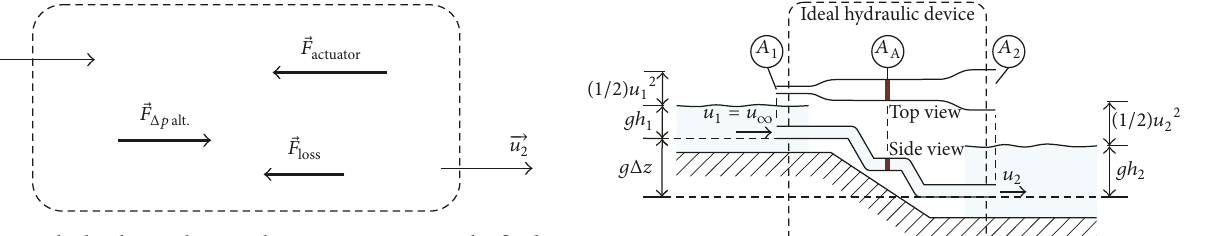
⃗𝐹 , actuator Figure 4: Cross section of an arbitrary ideal hydraulic installation. The water streamtube expands from cross-sectional area 𝐴 1 to 𝐴 with a corresponding increase in pressure. The actuator surface of area 𝐴 extracts hydraulic power from the fluid with a resulting A pressure drop; the streamtube then expands again so the outlet pressure reaches 𝑝 2 . The altitudes of the inlet, outlet, and actuator surface do not affect the machine’s performance and are never specified. In this model, neither ℎ 1 nor ℎ 2 are affected by the power extracted by the device, since it occupies only a small part of the channel.